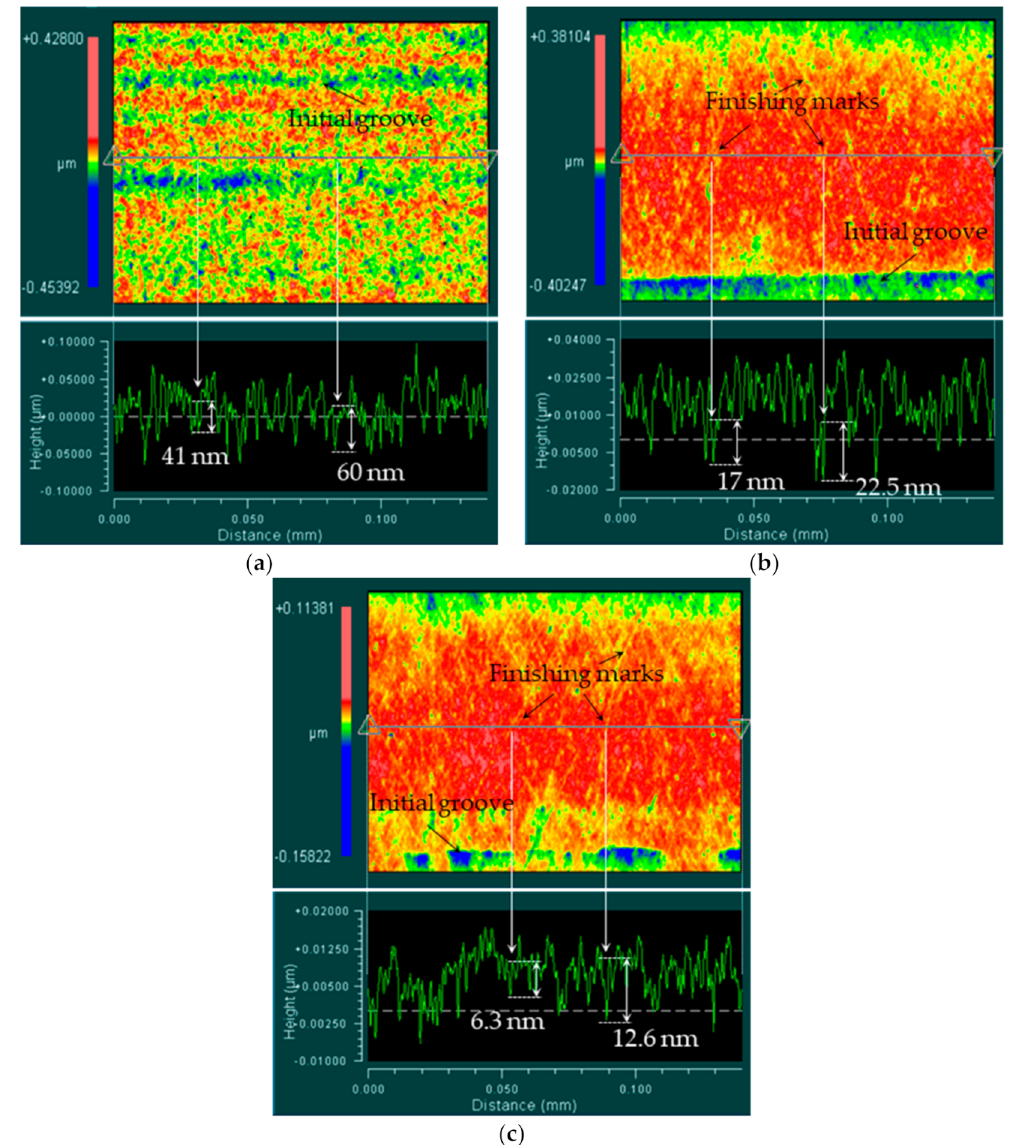
Figure 15. The Photographs of the workpiece surface after finishing (White Light Interferometers). ( a ) WA#6000; ( b ) WA#8000; ( c )